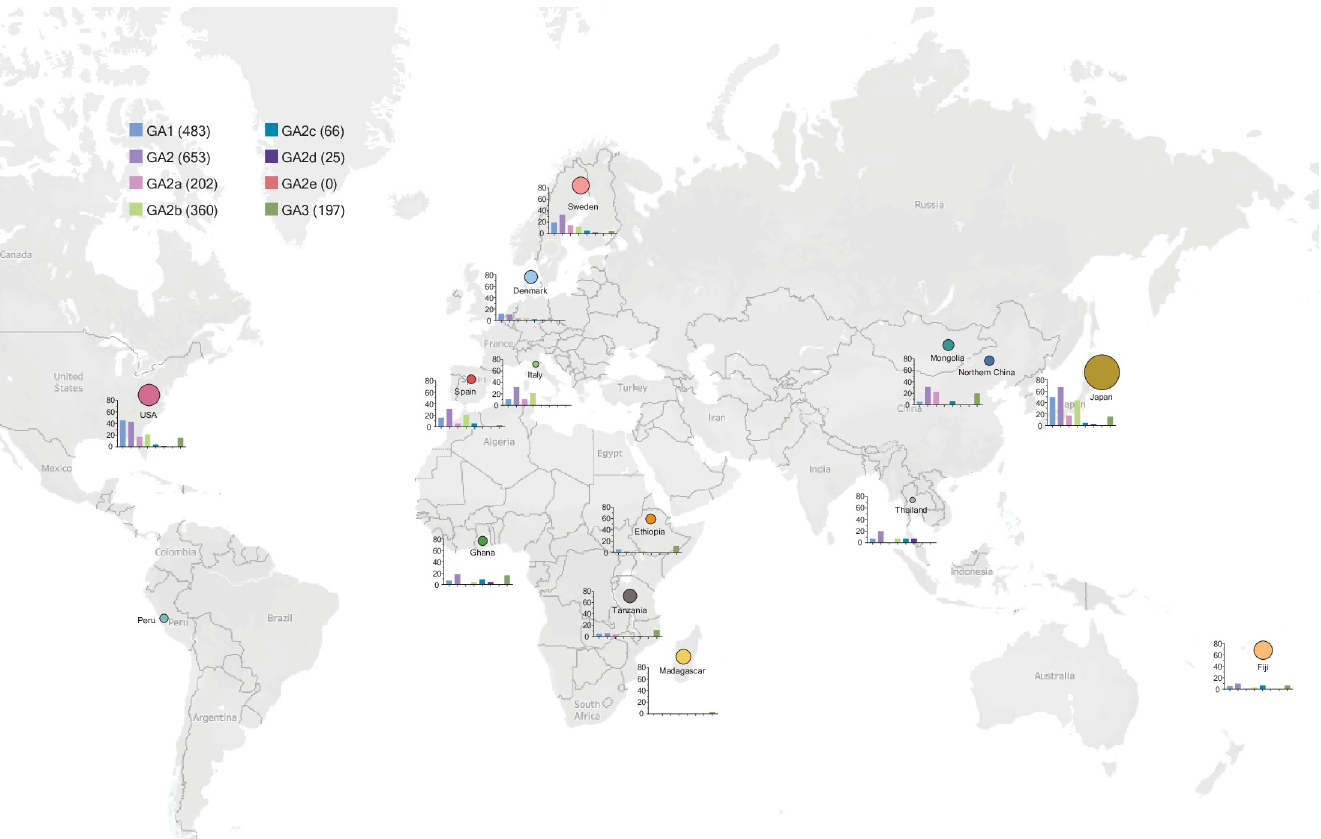
Fig 7. Distribution of the T6SS GA loci and subtypes in gut metagenomes from different human populations. The percentage of metagenomes with each GA1 and GA2 subtype of the total metagenomes for each population is shown by bar graph. The size of each population sampled is designated by the size of the circle. No GA loci were detected in the Peru metagenomic dataset. The exact numbers for each metagenomic dataset are reported in S7 Table as well as the health status of each individual in the various cohorts and the abundance of Bacteroides spp . and Prevotella spp in the metagenomic sample. Map data copyrighted OpenStreetMap contributors and available from